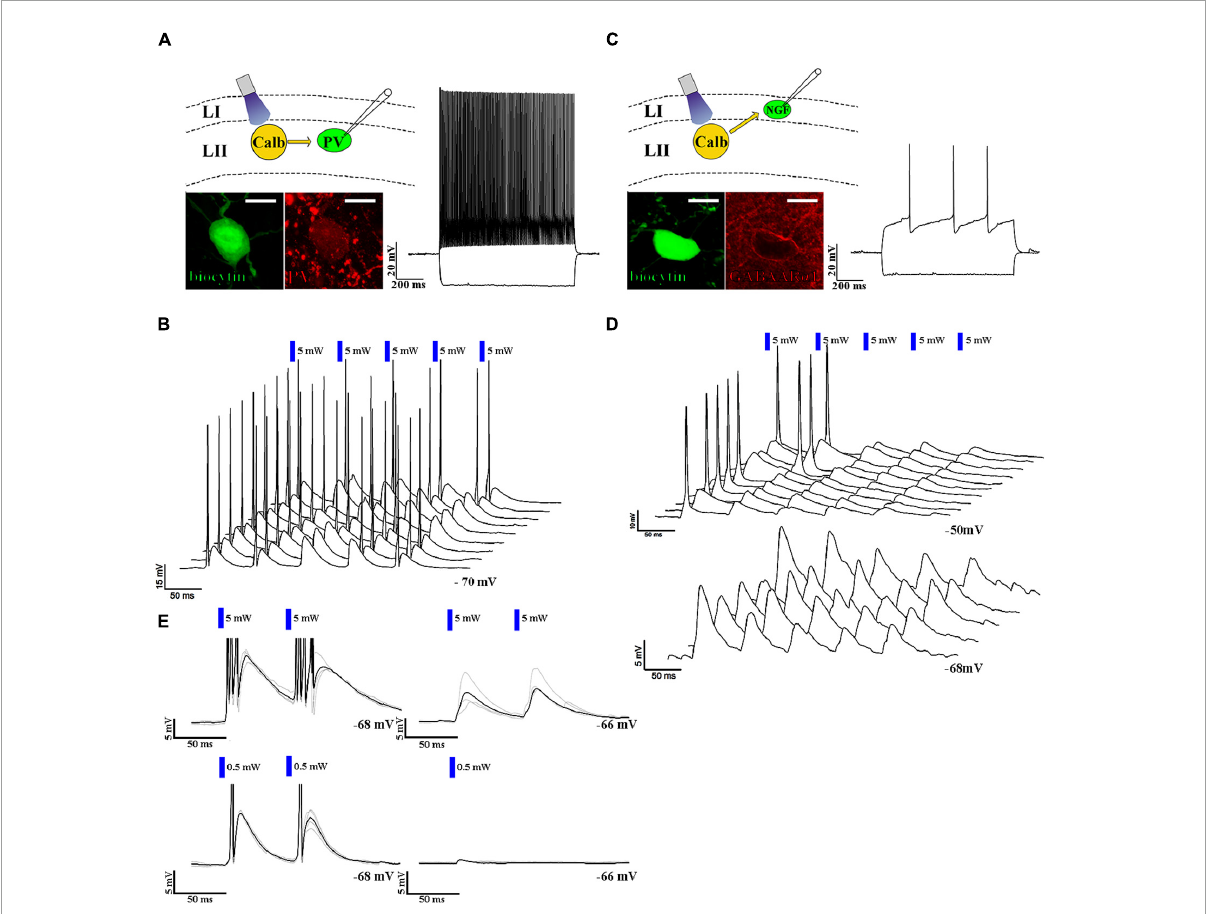
FIGURE3 Neurogliaform and non-neurogliaform cells react differently to layer II excitatory inputs. (A) Up left: schematic representation of the recording setup. Bottom left: confocal image of biocytin-filled parvalbumin-positive fast-spiking interneuron soma (scale bar: 10 µ m). Right: response to a 1 s current injection (RMP: –70 mV and –100 and +200 pA, scale bar: 20 mV and 200 ms). (B) 3D waterfall plot of the responses to five 5 ms long and 5 mW (blue bars) light pulses at 17 Hz. Sweeps were run 3 s apart. The last sweep in front (RMP: –70 mV, scale bars: 15 mV and 50 ms). (C) Up left: schematic representation of the recording setup. Bottom left: biocytin-filled GABAAR α 1 immunopositive neurogliaform cell body (scale bar: 10 µ m). Right: response to a 1 s current injection (RMP: –68 mV and –100 and +200 pA). (D) 3D waterfall plot of the responses to five 5 ms long, 5 mW (blue bars) light pulses at 17 Hz at resting membrane potential (–68 mV, bottom), and at a depolarized state (–50 mV, top) (scale bars: top: 10 mV and 50 ms, bottom 5 mV and 50 ms). (E) Response of the parvalbumin-positive fast-spiking interneuron (left) and the neurogliaform cell (right) to paired 5 mW (above) and 0.5 mW (below) intense 5 ms light-pulses (RMP: –68 and –66 mV, respectively, scale bars: 5 mV and 50 ms). The black trace represents the average, while the gray traces represent 4 consecutive sweeps. The delay between the two pulses was 60 ms. The response of the non-neurogliaform interneuron to paired 5 ms long light pulses with 0.5 mW light intensity was 11.9 mV at RMP: –68 mV, while the response of the neurogliaform cell to a single 5 ms long light pulse with the same intensity was 0.7 mV at RMP: –66 mV. It is noted that the response of neurogliaform cell to a 0.5 mW light pulse was tested only with a single 5 ms long light pulse (right, below).